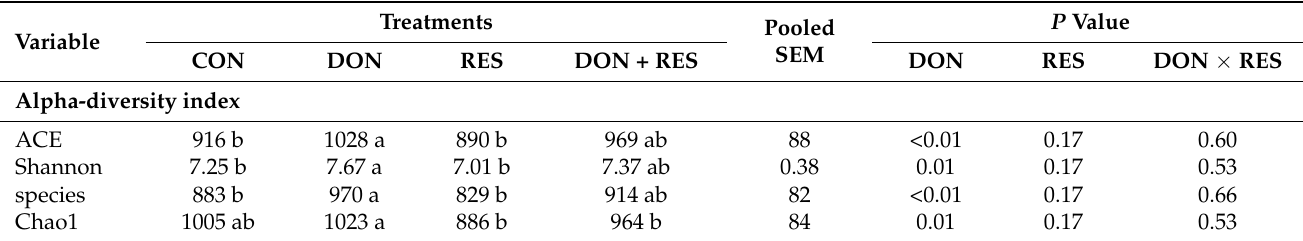
Table 8. Effect of resveratrol supplementation on the alpha-diversity of gut microbiota in DON- challenged piglets 1 .